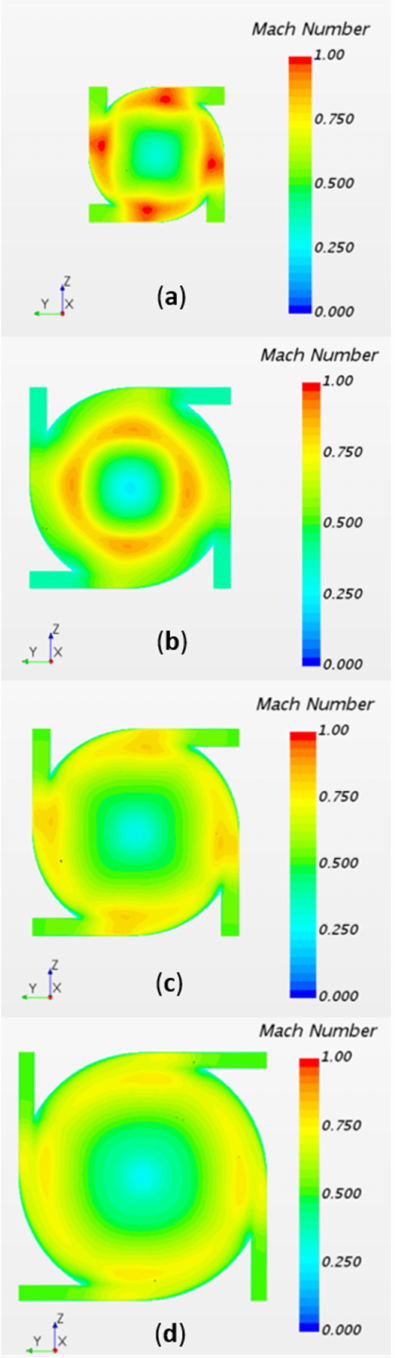
Figure 9. Mach number distribution in transverse vortex-chamber planes ( a ) case A, ( b ) case B, ( c ) case C, ( d ) case